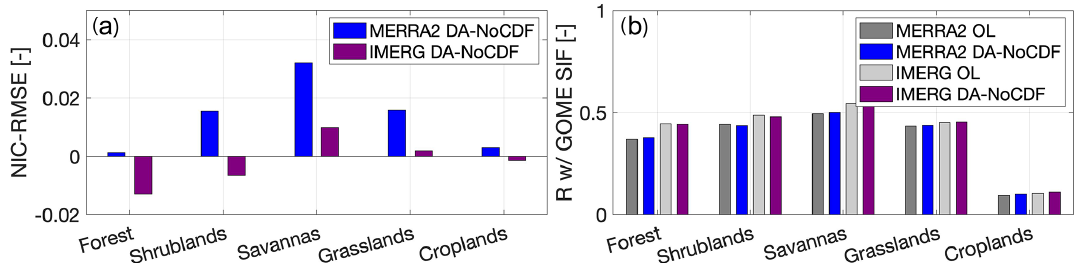
Figure 10. (a) Normalized information content (NIC) with respect to RMSE (RMSE OL versus RMSE DA − NoCDF ) is computed through comparison with FluxSat gross primary production (FS GPP). (b) Correlation with GOME solar-induced chlorophyll fluorescence (SIF) depicts the spatiotemporal consistency between the Noah-MP-modeled GPP and GOME SIF. Data from the summer months of water years 2016–2019 were used to compute the